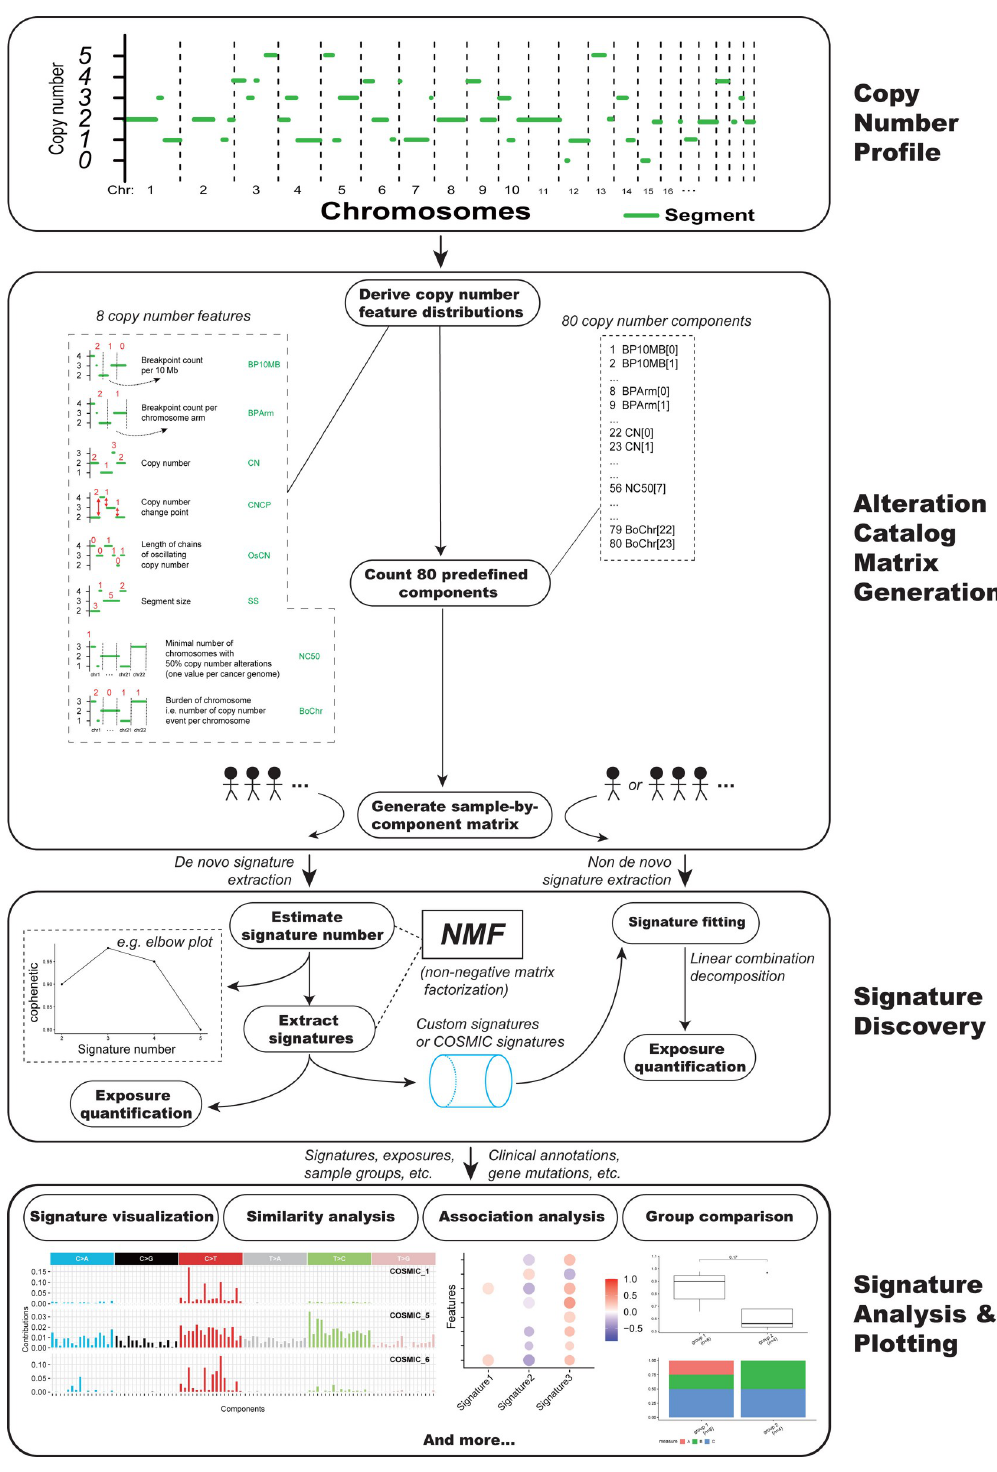
Fig 1. Copy number signature analysis